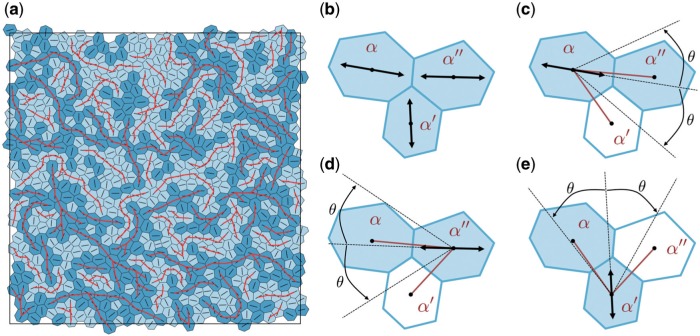
(a) An example of force chains in a monolayer, with 800 cells and \documentclass[12pt]{minimal}
\usepackage{amsmath}
\usepackage{wasysym} 
\usepackage{amsfonts} 
\usepackage{amssymb} 
\usepackage{amsbsy}
\usepackage{upgreek}
\usepackage{mathrsfs}
\setlength{\oddsidemargin}{-69pt}
\begin{document}
}{}$\Lambda=-0.1$\end{document}, \documentclass[12pt]{minimal}
\usepackage{amsmath}
\usepackage{wasysym} 
\usepackage{amsfonts} 
\usepackage{amssymb} 
\usepackage{amsbsy}
\usepackage{upgreek}
\usepackage{mathrsfs}
\setlength{\oddsidemargin}{-69pt}
\begin{document}
}{}$\Gamma=0.1$\end{document}, \documentclass[12pt]{minimal}
\usepackage{amsmath}
\usepackage{wasysym} 
\usepackage{amsfonts} 
\usepackage{amssymb} 
\usepackage{amsbsy}
\usepackage{upgreek}
\usepackage{mathrsfs}
\setlength{\oddsidemargin}{-69pt}
\begin{document}
}{}$P_{\mathrm{ext}=0}$\end{document}. Darker (lighter) shading denotes cells with \documentclass[12pt]{minimal}
\usepackage{amsmath}
\usepackage{wasysym} 
\usepackage{amsfonts} 
\usepackage{amssymb} 
\usepackage{amsbsy}
\usepackage{upgreek}
\usepackage{mathrsfs}
\setlength{\oddsidemargin}{-69pt}
\begin{document}
}{}$P^{\text{eff}}>0$\end{document}\documentclass[12pt]{minimal}
\usepackage{amsmath}
\usepackage{wasysym} 
\usepackage{amsfonts} 
\usepackage{amssymb} 
\usepackage{amsbsy}
\usepackage{upgreek}
\usepackage{mathrsfs}
\setlength{\oddsidemargin}{-69pt}
\begin{document}
}{}$(<0)$\end{document}. Short line segments indicate the principal axis of the stress tensor for each cell (see Fig. 4). Long red lines identify chains satisfying (D.1) with \documentclass[12pt]{minimal}
\usepackage{amsmath}
\usepackage{wasysym} 
\usepackage{amsfonts} 
\usepackage{amssymb} 
\usepackage{amsbsy}
\usepackage{upgreek}
\usepackage{mathrsfs}
\setlength{\oddsidemargin}{-69pt}
\begin{document}
}{}$\theta = \pi / 4$\end{document}. (b–e) identify force chains. Red lines represent vectors running between cell centroids. Black double sided arrows indicate the principal axis of stress. b) Cell \documentclass[12pt]{minimal}
\usepackage{amsmath}
\usepackage{wasysym} 
\usepackage{amsfonts} 
\usepackage{amssymb} 
\usepackage{amsbsy}
\usepackage{upgreek}
\usepackage{mathrsfs}
\setlength{\oddsidemargin}{-69pt}
\begin{document}
}{}$\alpha$\end{document} has been selected to start a chain, and cells \documentclass[12pt]{minimal}
\usepackage{amsmath}
\usepackage{wasysym} 
\usepackage{amsfonts} 
\usepackage{amssymb} 
\usepackage{amsbsy}
\usepackage{upgreek}
\usepackage{mathrsfs}
\setlength{\oddsidemargin}{-69pt}
\begin{document}
}{}$\alpha^{\prime}$\end{document} and \documentclass[12pt]{minimal}
\usepackage{amsmath}
\usepackage{wasysym} 
\usepackage{amsfonts} 
\usepackage{amssymb} 
\usepackage{amsbsy}
\usepackage{upgreek}
\usepackage{mathrsfs}
\setlength{\oddsidemargin}{-69pt}
\begin{document}
}{}$\alpha^{\prime\prime}$\end{document} are found to satisfy (D.1c). (c-e) Only \documentclass[12pt]{minimal}
\usepackage{amsmath}
\usepackage{wasysym} 
\usepackage{amsfonts} 
\usepackage{amssymb} 
\usepackage{amsbsy}
\usepackage{upgreek}
\usepackage{mathrsfs}
\setlength{\oddsidemargin}{-69pt}
\begin{document}
}{}$\alpha^{\prime\prime}$\end{document} is selected to join the chain as it satisfies both (D.1a) (c) and (D.1b) (d). \documentclass[12pt]{minimal}
\usepackage{amsmath}
\usepackage{wasysym} 
\usepackage{amsfonts} 
\usepackage{amssymb} 
\usepackage{amsbsy}
\usepackage{upgreek}
\usepackage{mathrsfs}
\setlength{\oddsidemargin}{-69pt}
\begin{document}
}{}$\alpha^{\prime}$\end{document} is excluded because is fails (D.1a) (c), despite satisfying (D.1b) (e). (Colour in online.)